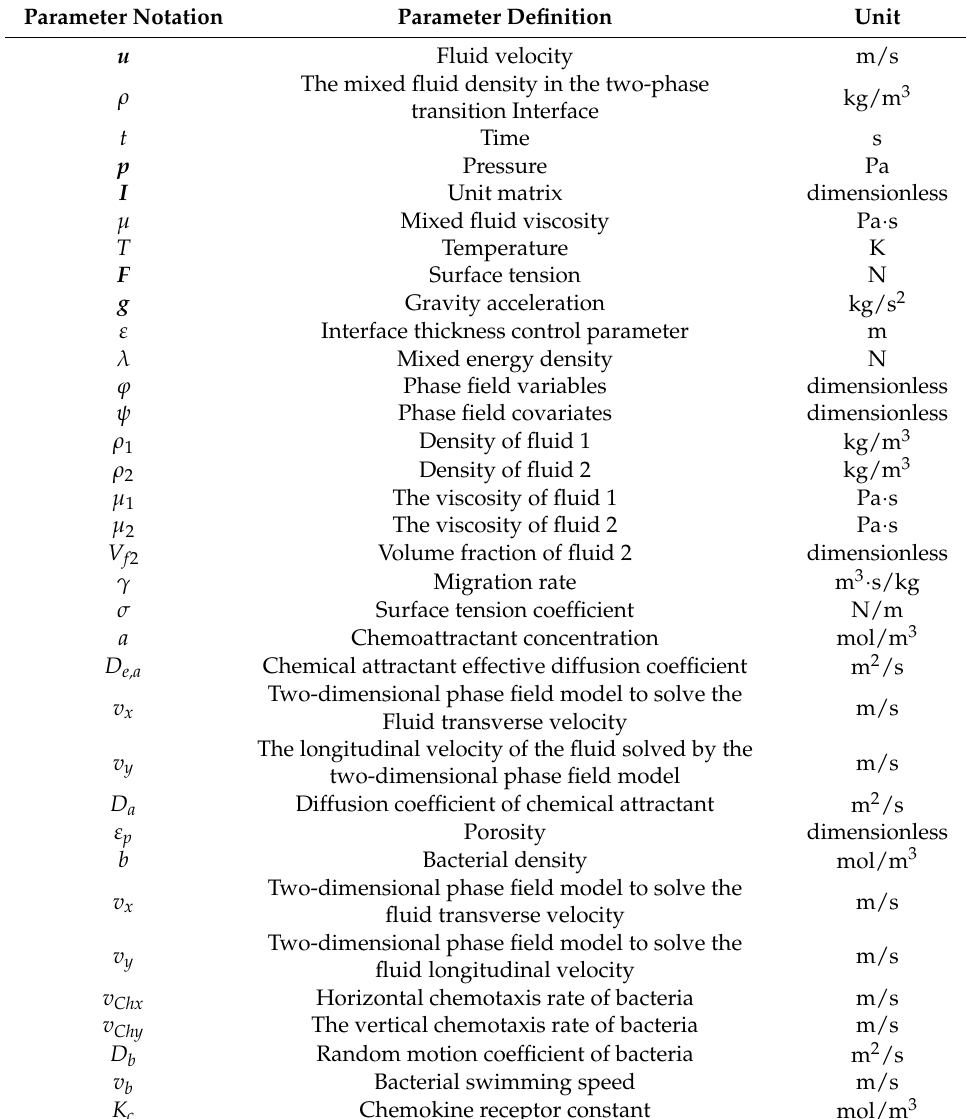
Table 2. Nomenclature section to the